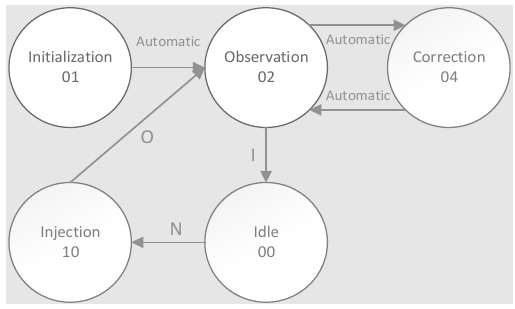
Figure 23. SEM IP state diagram.